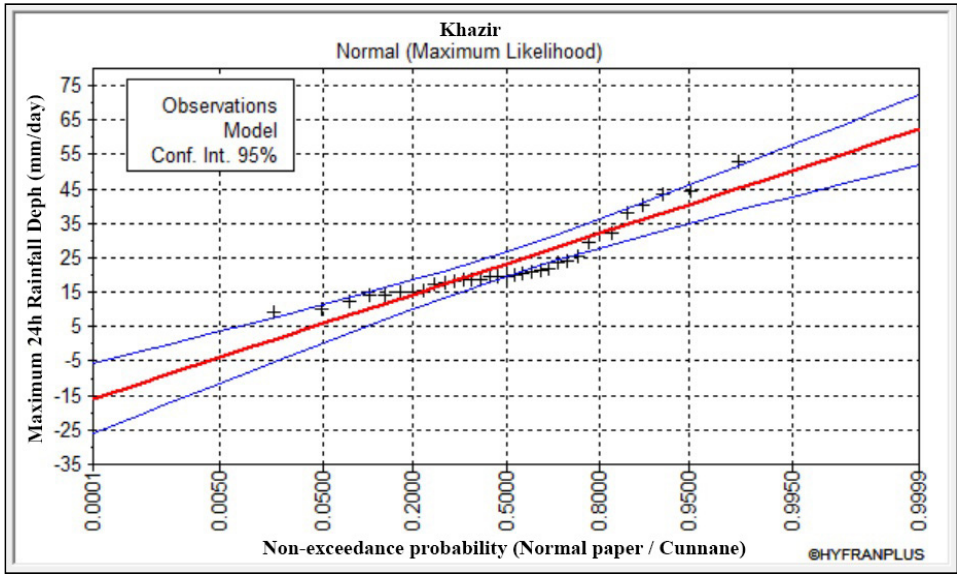
Figure 5. Curve values (intensity, duration, frequency) for the study station. Table 5. Percentage of rainfall value at different periods (Bell’s Ratios).